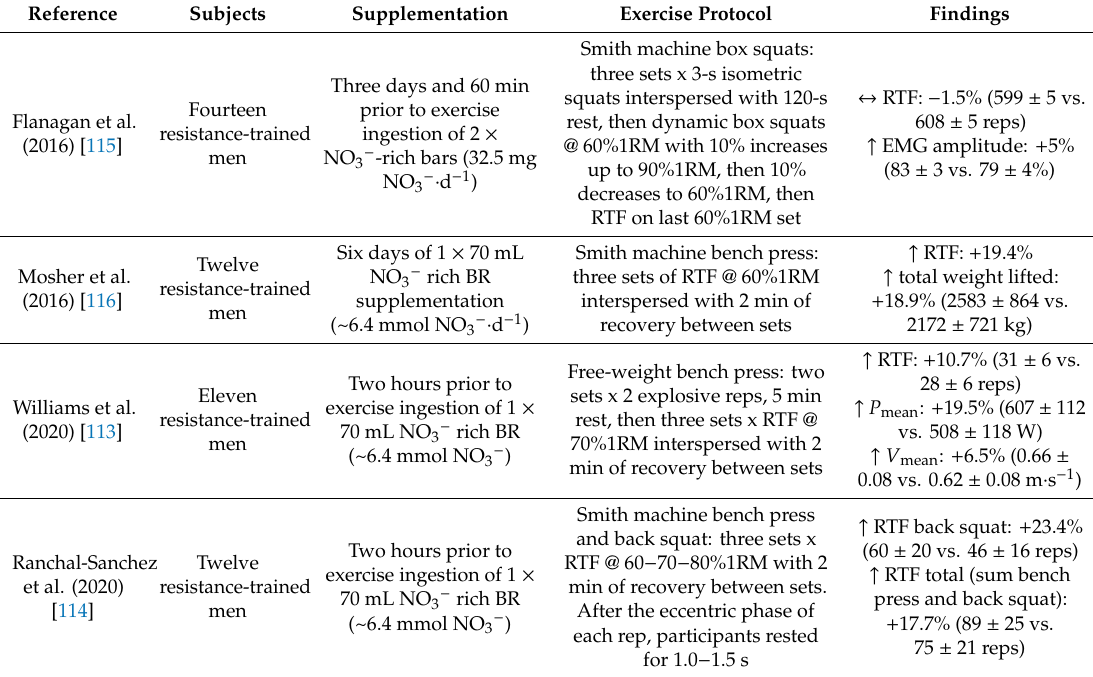
Table 1. Studies assessing the e ff ects of dietary NO 3 − supplementation on resistance exercise performance in